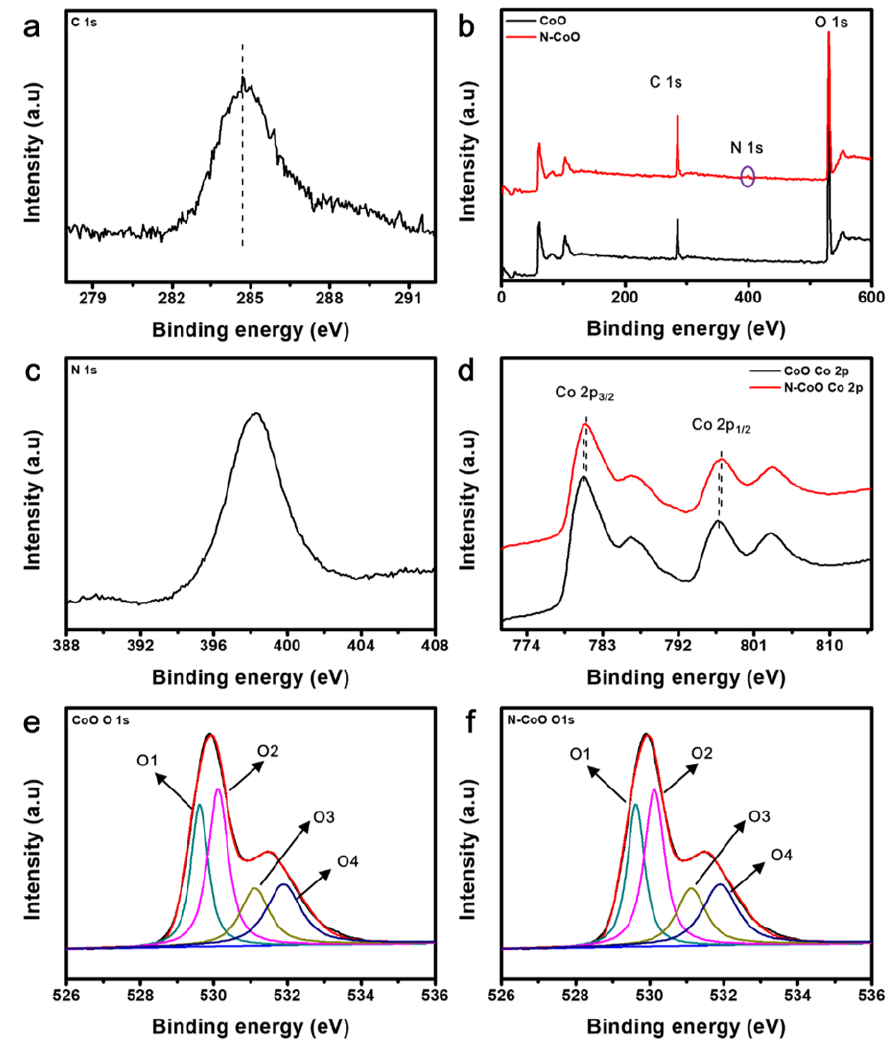
Figure 3. ( a ) High-resolution XPS spectra of C 1s. ( b ) Survey scan spectra of CoO and N-CoO. ( c ) High-resolution XPS spectra of N 1s. ( d ) High-resolution XPS spectra of Co 2p. ( e ) High-resolution XPS spectra of O in CoO. ( f ) High-resolution XPS spectra of O in